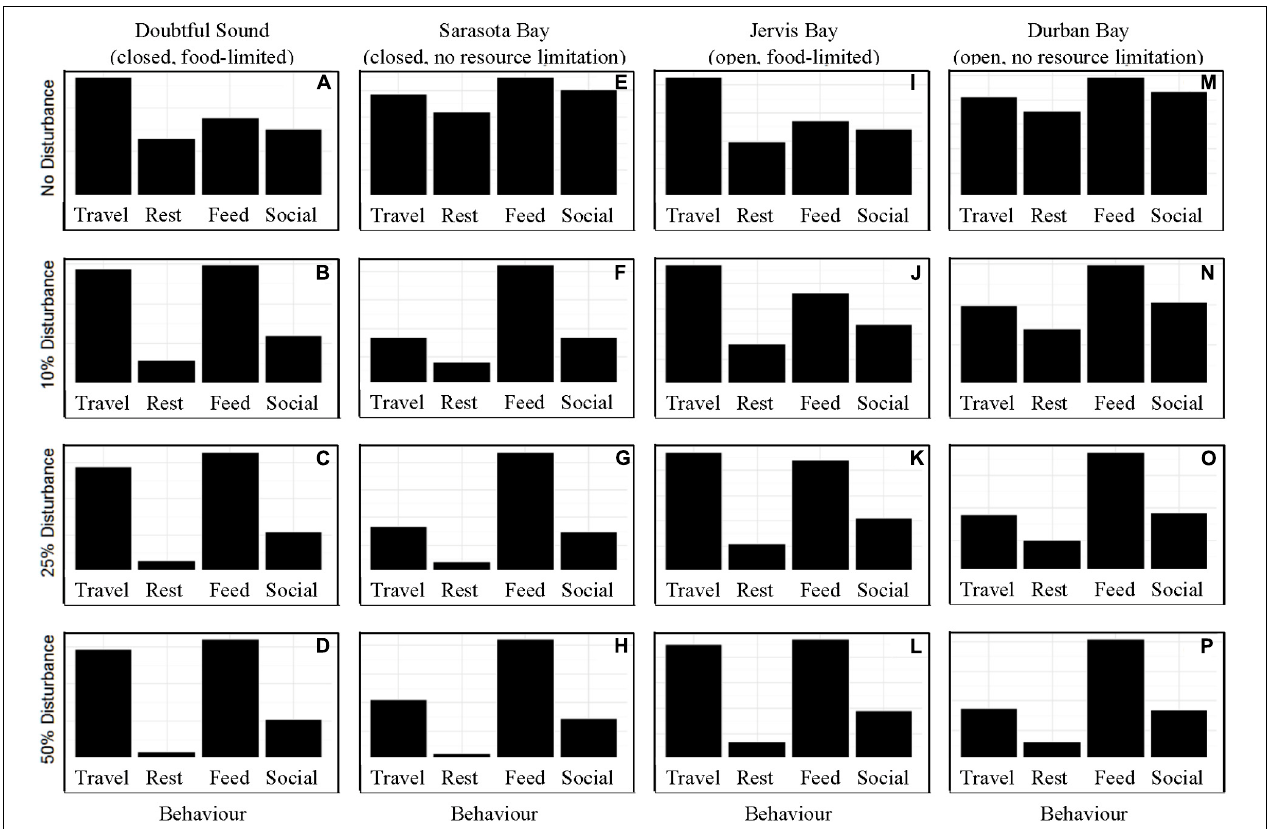
FIGURE 1 | The activity time budgets for the four simulated populations (columns), Doubtful Sound (A–D) , Sarasota Bay (E–H) , Jervis Bay (I–L) , and Durban Bay (M–P) , under four different disturbance scenarios (rows): no disturbance (A,E,I,M) and a 10% (B,F,J,N) , 25% (C,G,K,O) , or 50% (D,H,L,P) chance of an individual being disturbed when in the area used by whale-watching vessels. The four behaviors in which the dolphins can take part are: traveling (Travel), resting (Rest), foraging (Feed), and socializing